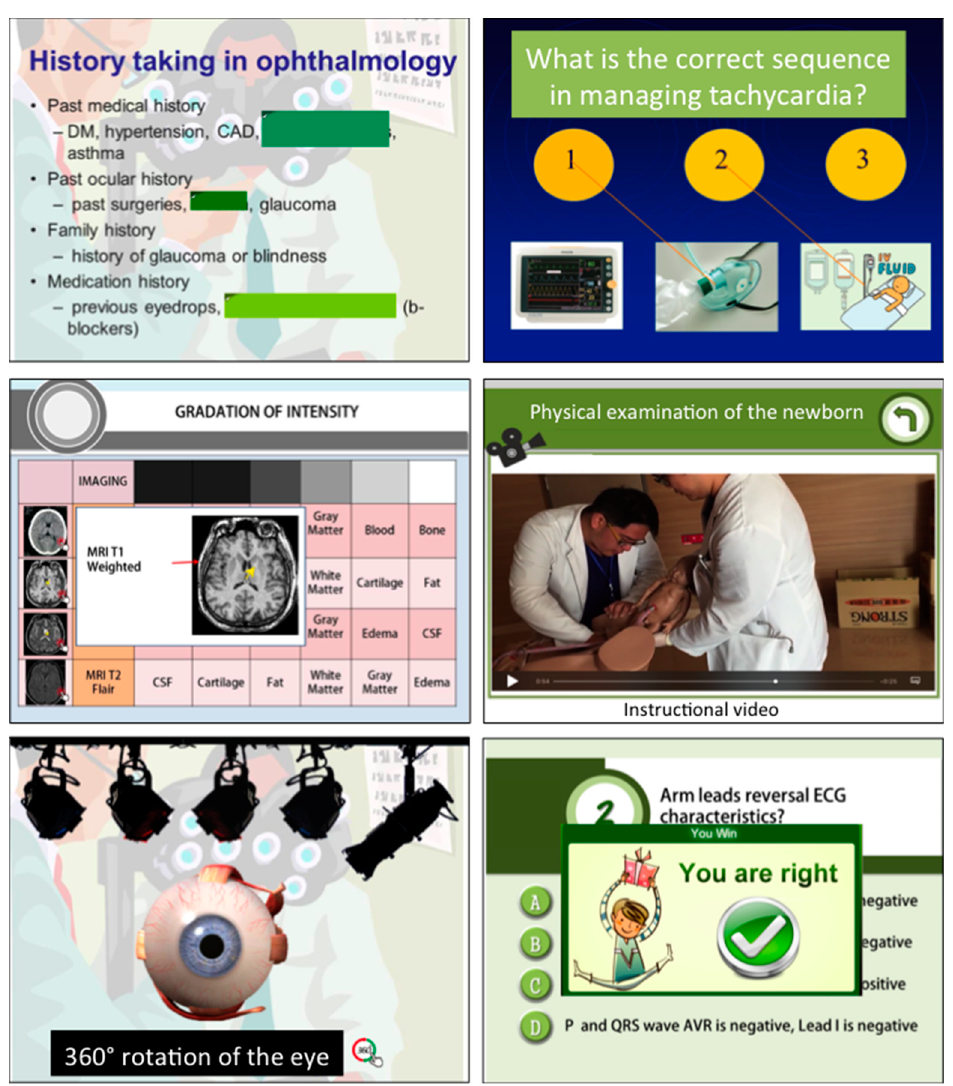
Figure 3. Interface of various interactive functions in our eBook module, including simulation models in anatomy, instructional videos, labeling exercises, comprehensive multi-page assessments, and interactive scenarios with instructive feedback.